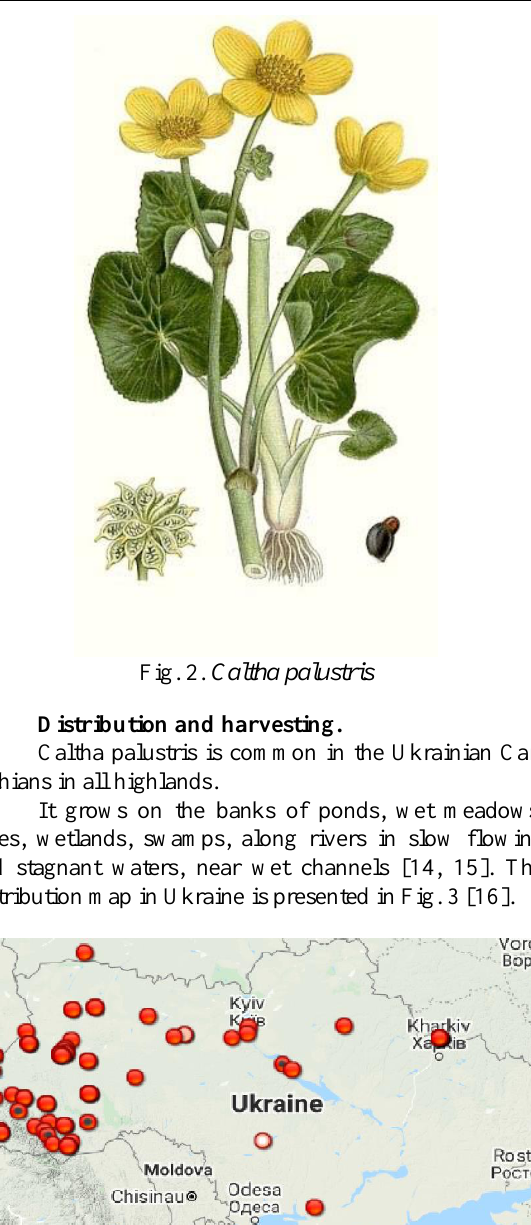
Fig. 1. Caltha palustris